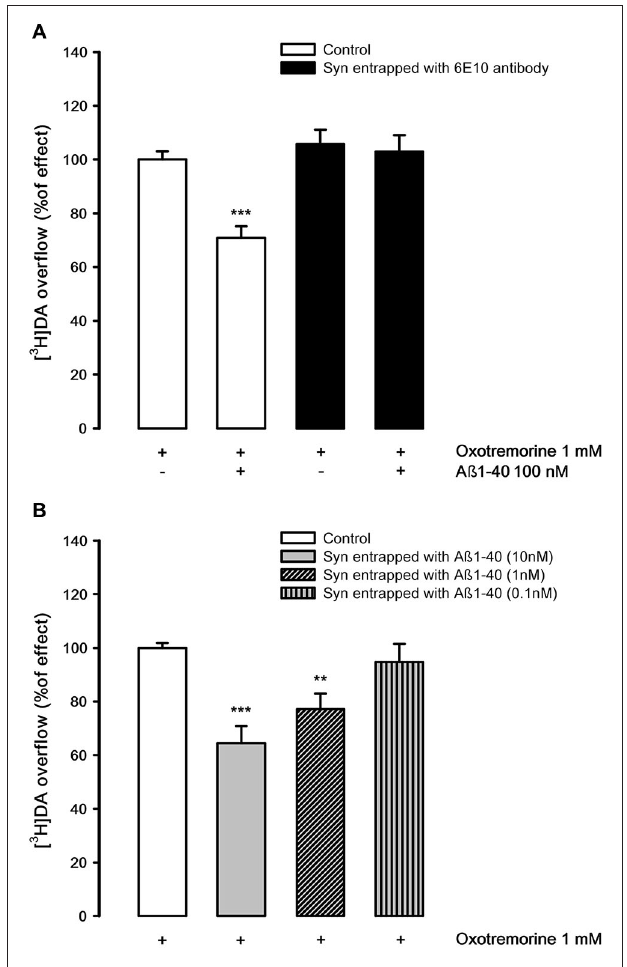
FIGURE 6 | (A) Effects of A β 1-40 added to the medium on oxotremorine-evoked [ 3 H]DA overflow from rat NAc synaptosomes entrapped with 6E10 monoclonal antibody. Data are means ± SEM of three experiments run in triplicate. *** P < 0.001 versus oxotremorine (control synaptosomes). Two-way ANOVA followed by Bonferroni post-hoc test. (B) Effects of A β 1-40 entrapped in rat NAc synaptosomes